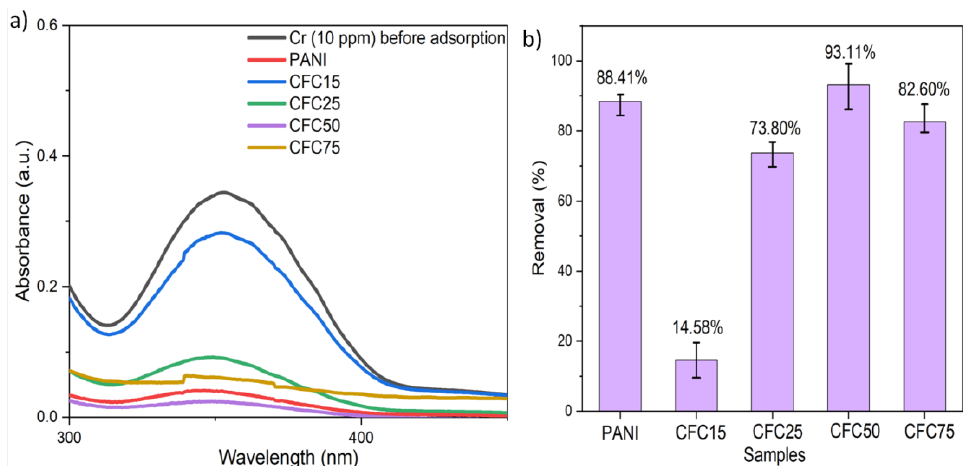
Figure 3. ( a ) UV-Vis spectra depicting the adsorption performance of the prepared samples ( b ) % adsorption of prepared samples for Chromium adsorption (pH = 6, adsorbent dosage = 0.25 mg/mL, Cr concentration = 10 ppm, contact time = 30